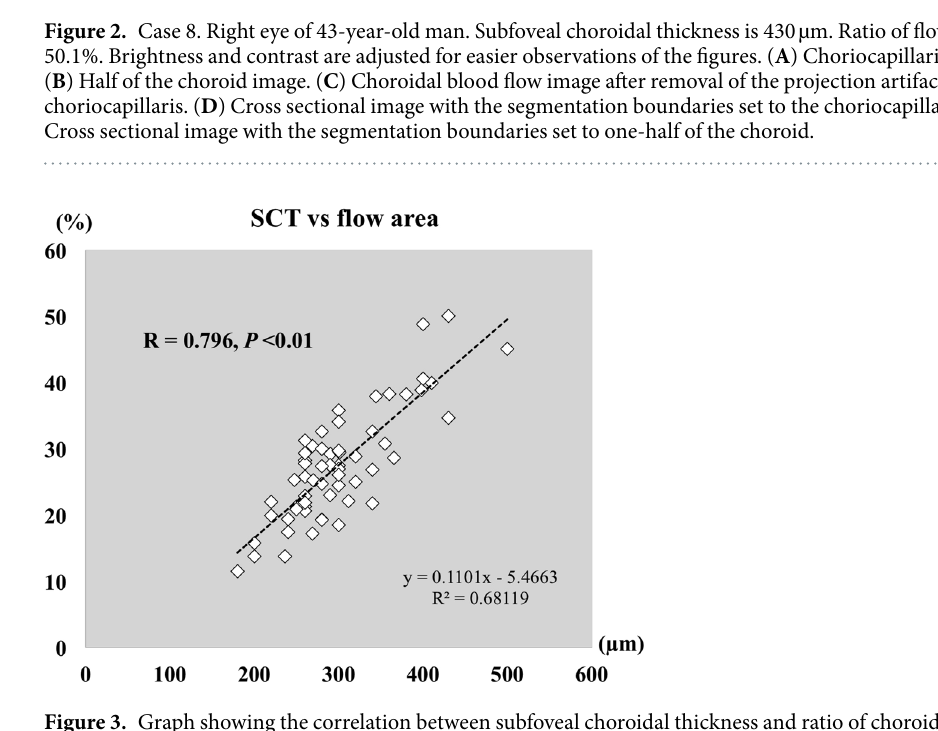
Figure 3. Graph showing the correlation between subfoveal choroidal thickness and ratio of choroidal blood flow. R = 0.796, P <